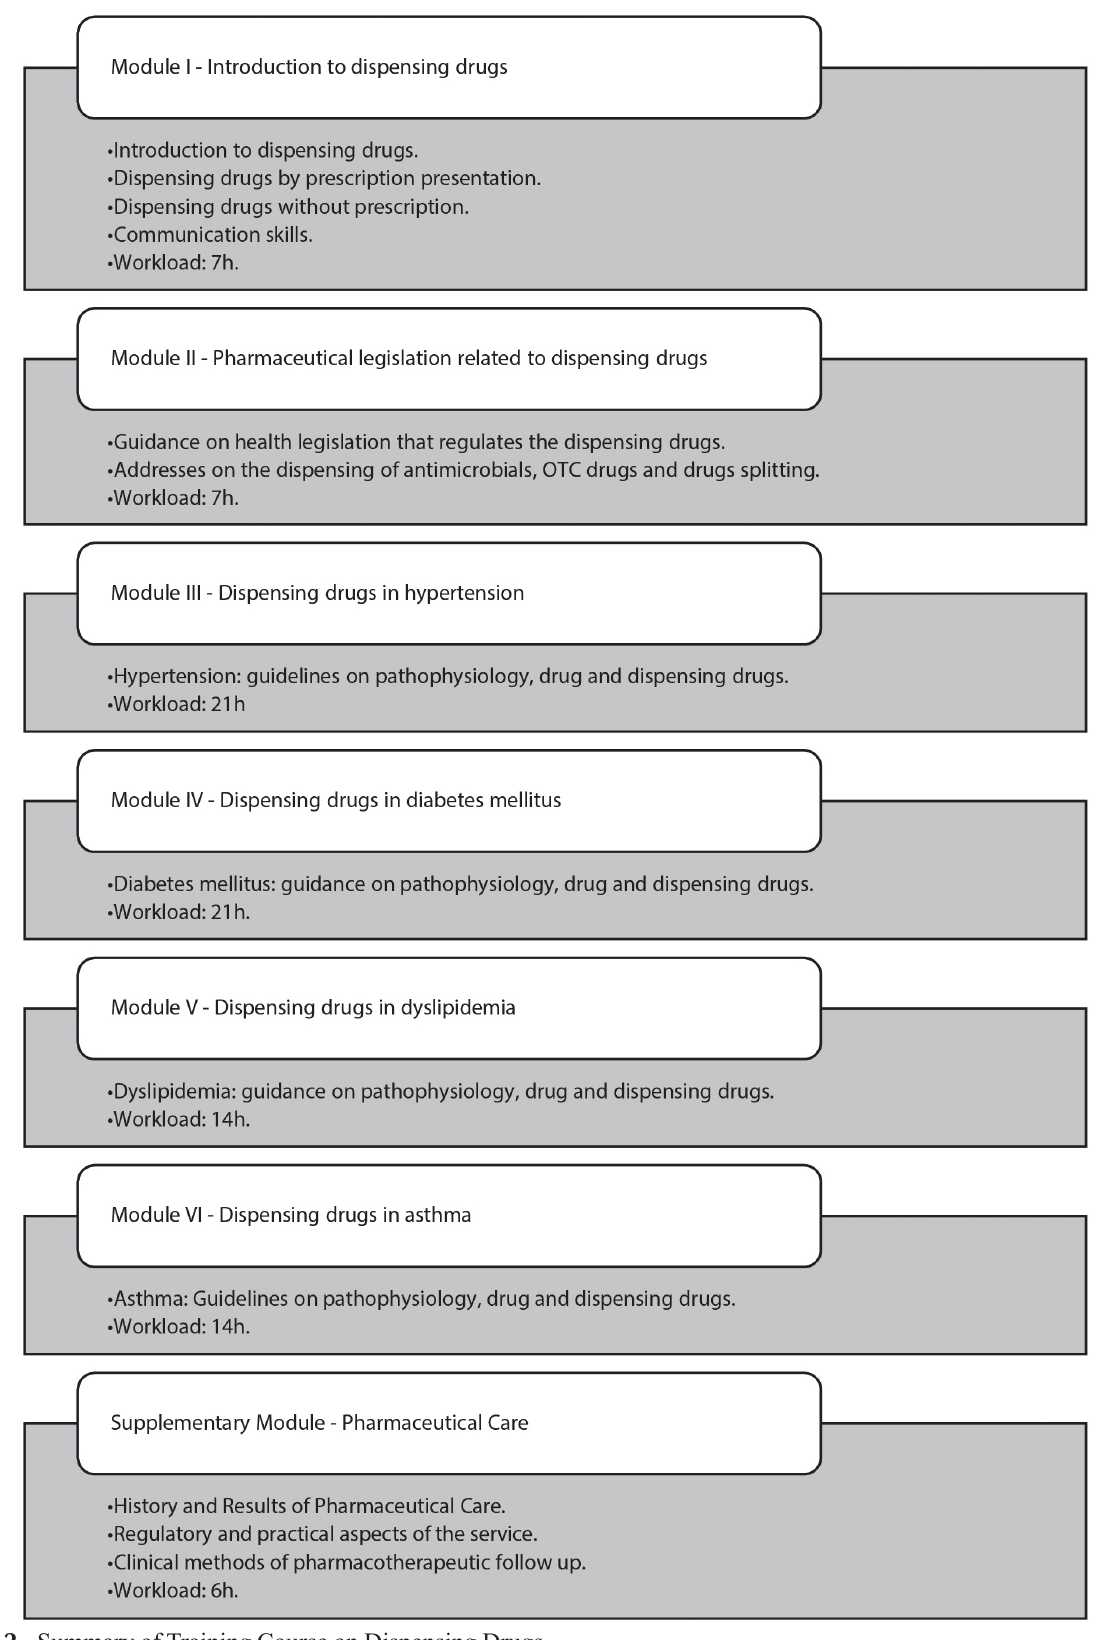
FIGURE 2 - Summary of Training Course on Dispensing